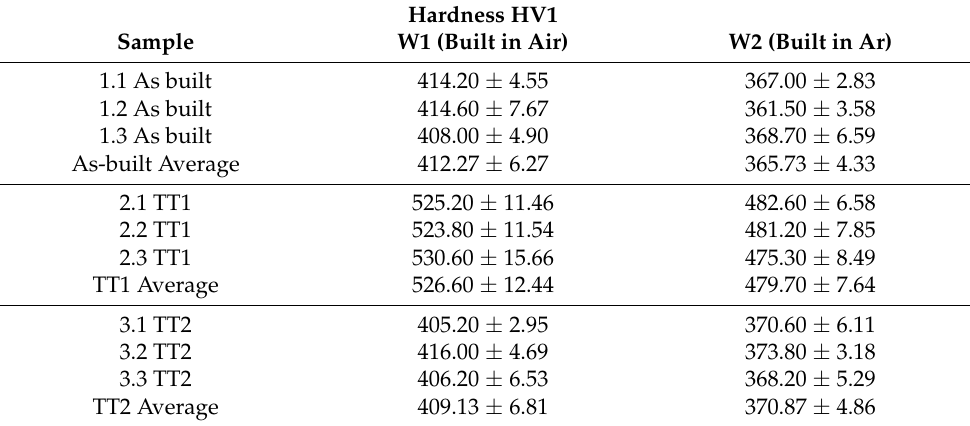
Table 3. Hardness values of the as-built and TT1- and TT2-treated specimens under both tested atmospheric